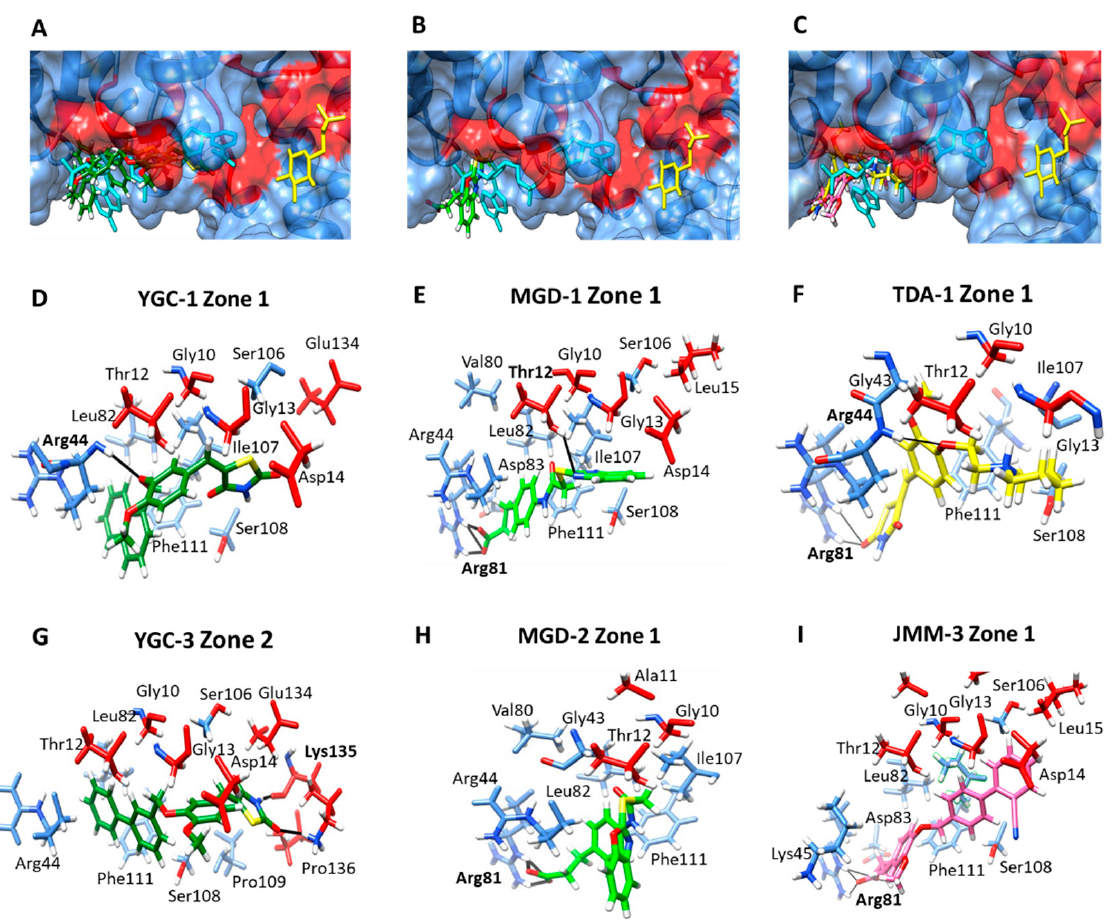
Figure 6. Molecular docking of the compounds in zone 1 on the HpG6PD model. In a general view of the binding cavities with the HpG6PD protein of ( A ) YGC-1 and YGC-2 , ( B ) MGD-1 and MGD-2 , and ( C ) TDA-1 and JMM-3 . The NADP + and G6P molecules are shown in cyan and yellow color, respectively; ( D , G ) zoom on the interactions of YGC-1 and YGC-3 ; ( E , H ) zoom on the interactions of MGD-1 and MGD-2 ; ( F , I ) zoom on the interactions of TDA-1 and JMM-3 ligands with the HpG6PD model. The H-bond interactions are shown in black, and the amino acid residue is marked in bold. Table 2. Interactions of compounds with HpG6PD. The amino acids in bold are the hydrogen bond interactions. Compound Interactions Δ G (kcal/mol) G6P His165, Tyr166, Lys169, Glu201, Asp220, His225, Lys311, Ans316 NADP +